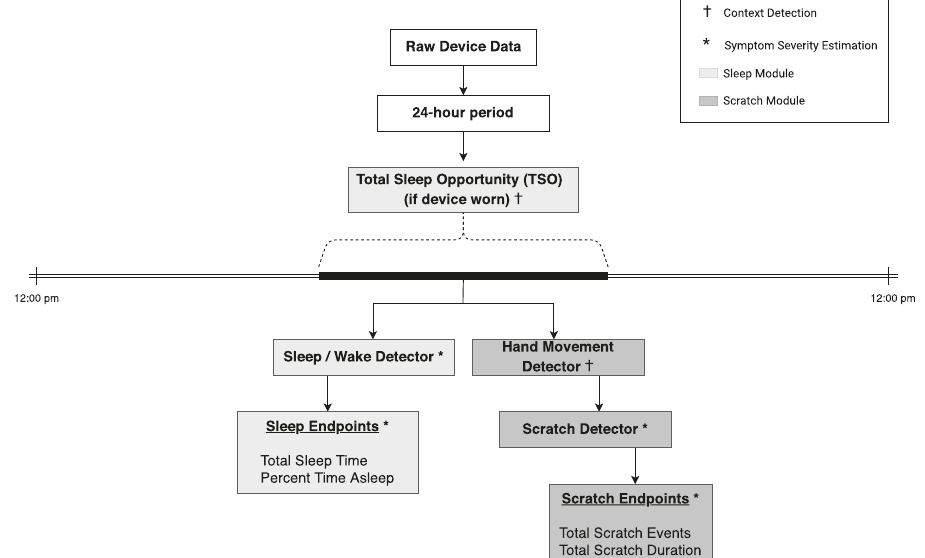
Fig. 3 Flowchart highlighting hierarchical approach for detection and assessment of sleep and nighttime scratch using accelerometer data from a wrist-worn device. Raw accelerometer data are fi rst sliced to a 24-h period (12:00 PM – 12:00 PM), then segmented to the total sleep opportunity (TSO) window, and fi nally measures of sleep and scratch are computed during the TSO